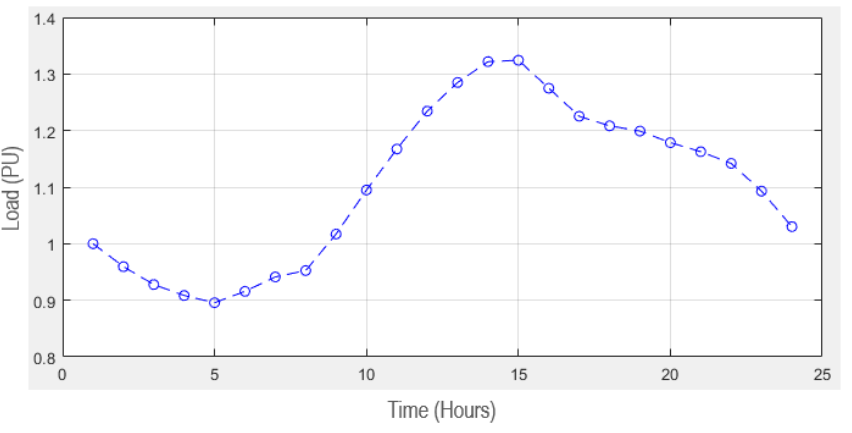
Figure 6. Houston load 24-h profile in PU